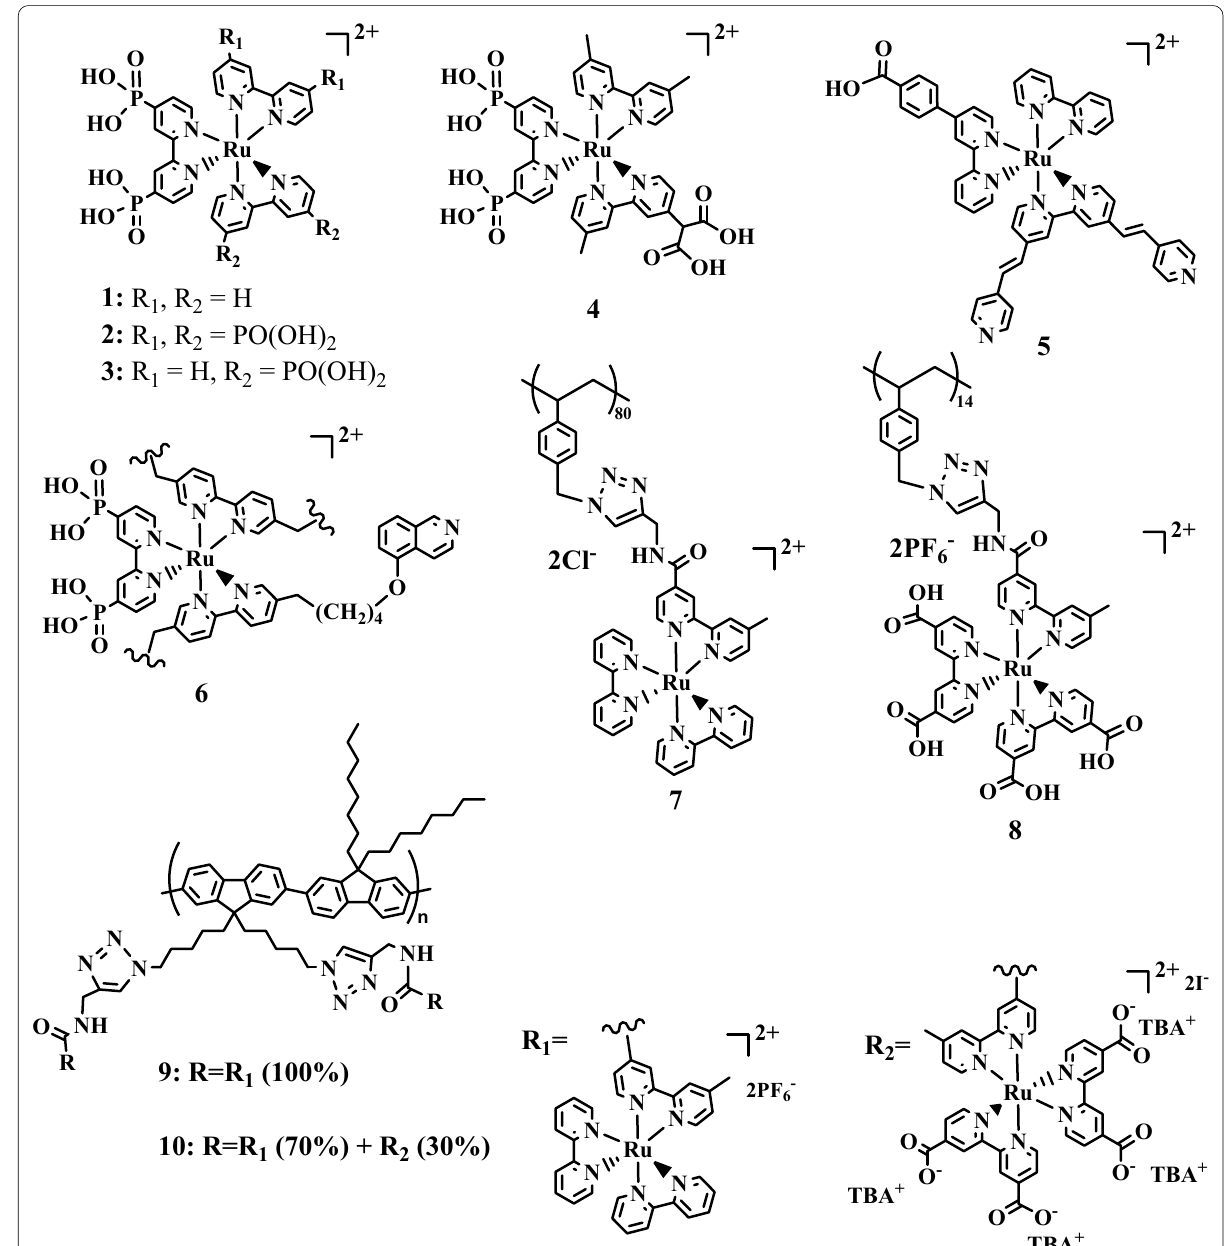
Fig. 4 Examples of ruthenium polypyridyl chromophores 1 , [60] 2 , [63] 3 , [61, 65] 4 , [13] 5 , [64] 6 , [12] 7 , [66] 8 , [67] 9 , [68] and 10 [68] used in DSPEC related studies. TBA +